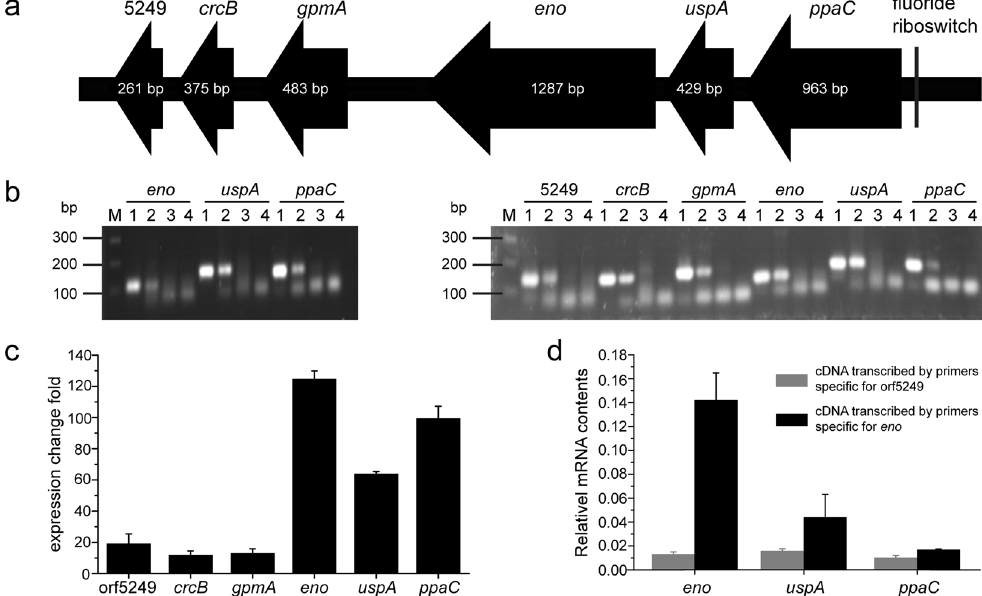
Figure 3. Genetic organization and expression of the Is3G fragment. ( a ) Schematic representation of the Is3G fragment loci. Thick black line, chromosomal DNA; filled arrows, six open reading frames with corresponding gene size; dotted lines, complementary DNA (cDNA) transcribed with gene-specific primers for orf5249 and eno in the 3 ′ direction. ( b ) Analyses of reverse transcription (RT)-PCR products (left, cDNA transcribed with gene-specific primers for orf5249; right, cDNA transcribed with gene-specific primers for eno ). Lanes: M, 100-base-pair (bp) DNA ladder; 1, PCR positive control using E . cloacae FRM genomic DNA as a template; 2, RT-PCR using E . cloacae FRM cDNA as a template; 3, negative control using E . cloacae FRM RNA as a template; 4, PCR negative control without template. ( c ) Transcriptional analysis of the genes orf5249, crcB , gpmA , eno , uspA , and ppaC in E . cloacae FRM cultured with 1,000 mg/L fluoride in comparison with culture in the absence of fluoride using quantitative RT-PCR. Transcript levels of the tested genes were normalized to the 16 S rRNA gene. ( d ) The relative transcription levels of the genes eno , uspA , and ppaC . The 16 S rRNA gene was used as an internal control for